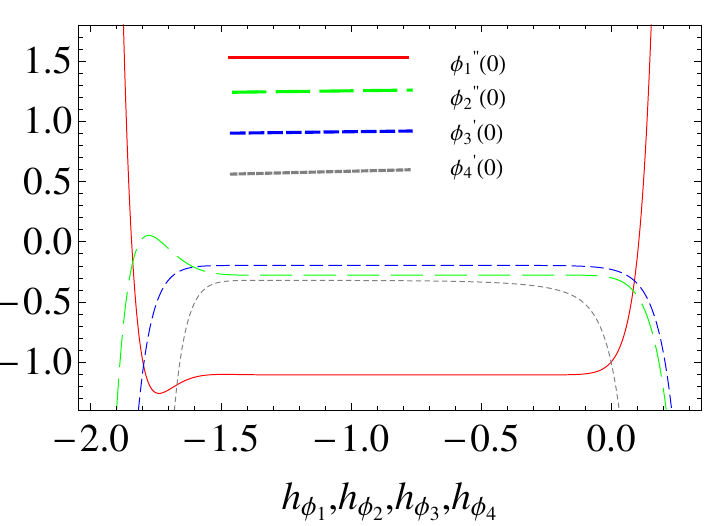
( 0 ) , φ (cid:48)(cid:48) ( 0 ) , φ (cid:48) ( 0 ) , and φ (cid:48) ( 0 ) . 2 3 1 4